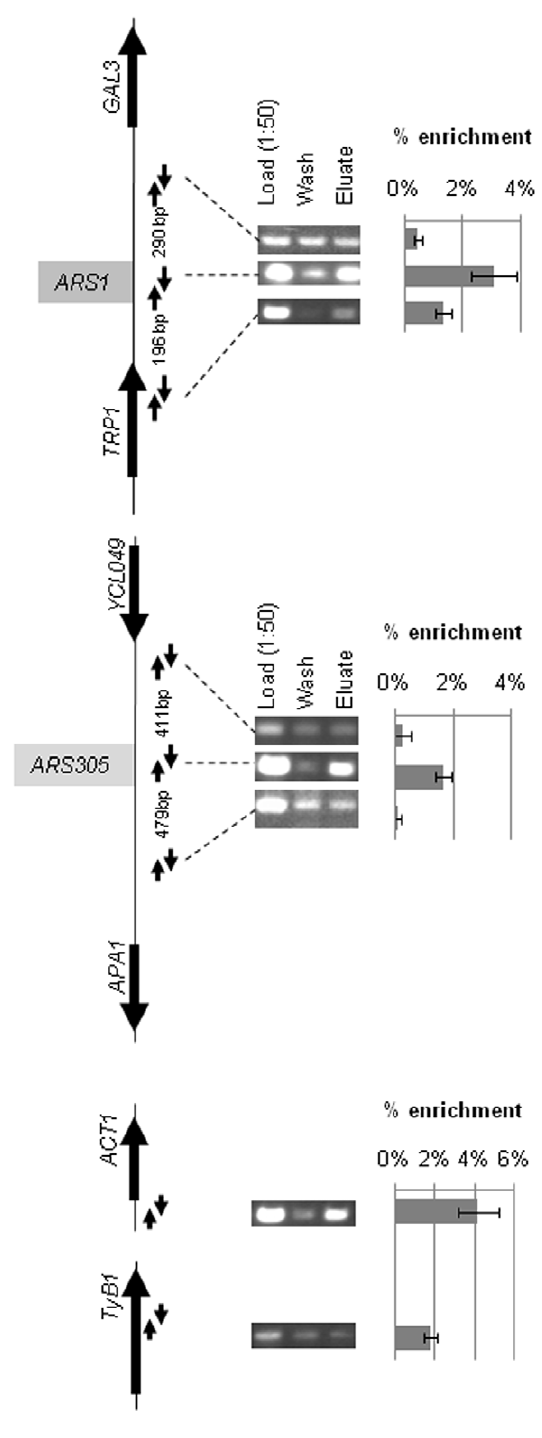
Figure 4. Gcn5p associates with chromosomal origins of DNA replication. Maps of the four genomic loci analyzed are shown on the left. Exponentially growing MYC18-GCN5 cells were cross-linked with formalde- hyde and immunoprecipitated with anti-MYC antibodies and the precipitated DNA was quantified by PCR in triplicate. The per cent of signal from each fragment in the anti-MYC immunoprecipitate versus Load (diluted 1:50) was calculated and plotted in the graphs on the right together with the standard deviation in the three PCR reactions. The arrows in the diagrams represent the pairs of PCR primers used. The distance between the PCR fragments is shown between the pairs of arrows. A typical outcome of one of two independent experiments is shown.